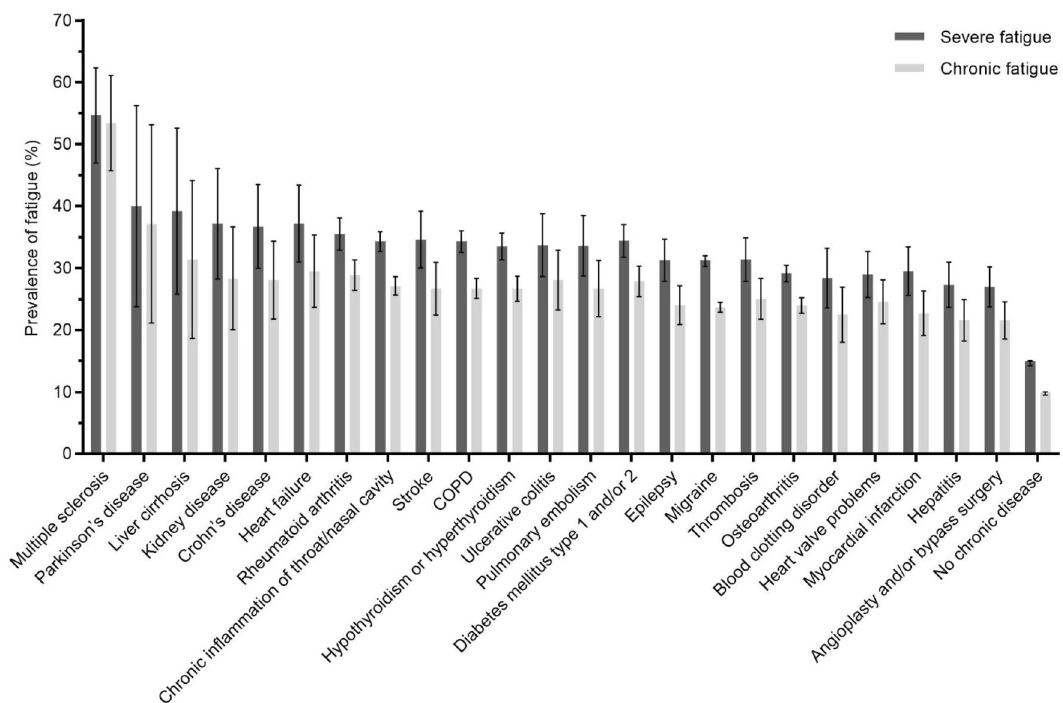
Figure 2. Prevalence and 95% Confidence Intervals of severe and chronic fatigue across 23 chronic diseases and in subjects without a chronic disease. Of note: (1) subjects that did not report their fatigue duration were omitted from the calculation of chronic fatigue, (2) the bars represent participants with multi-morbidity, hence subjects can be represented multiple times in the analyses. COPD chronic obstructive pulmonary